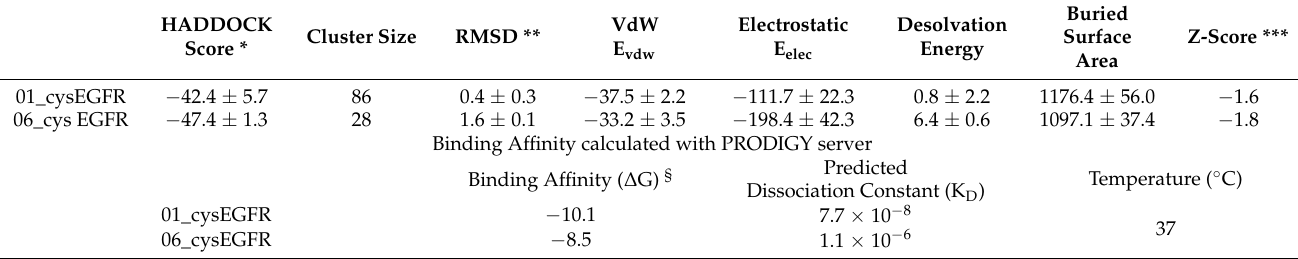
Figure 2. Three-dimensional front view of EGFR. Domain I (1–165 amino acid residues), II (166–310 amino acid residues), III (311–79 amino acid residues), and IV (480–614 amino acid residues) are colored in grey, green, orange and blue, respectively. The cavity region between Domain I and III in the EC region is highlighted in the lateral popup and colored in grey dots (PDB code: 3NJP). Table 1. HADDOCK and PRODIGY results of 01_cys EGFR and 06_cys EGFR—EGFR